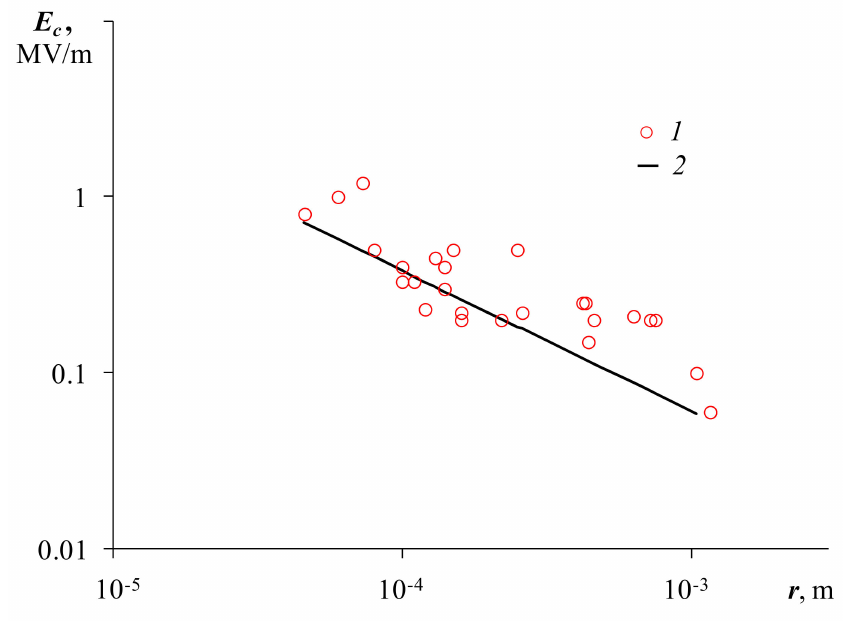
Figure 5. Dependence of the critical electric field strength E c on the average droplet radius r . (1)—experimental values and (2)—theoretical